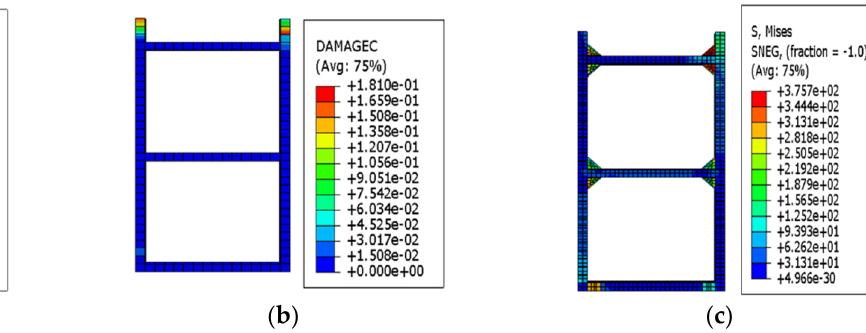
Figure 6. Stress contour plots at a drift ratio of 1/500. ( a ) Stress contour plot of the wall concrete; ( b ) stress contour plot of the concrete in the boundary steel tube; and ( c ) von Mises stress contour plot of the boundary steel tube.